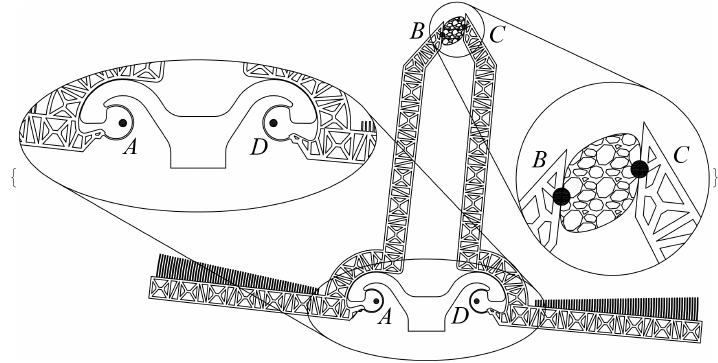
Figure 2. The gripping system in a generic